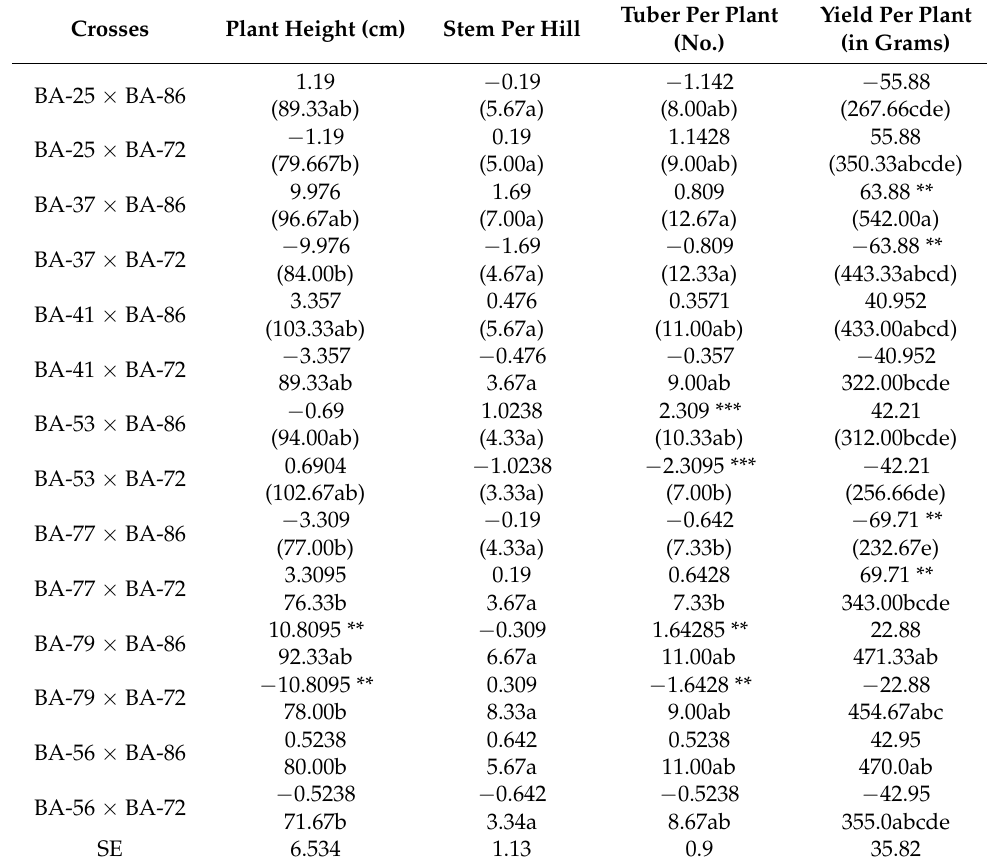
Table 6. Estimates of SCA effects of crosses for yield and yield characteristics grown in BSPC during the 2020–2021